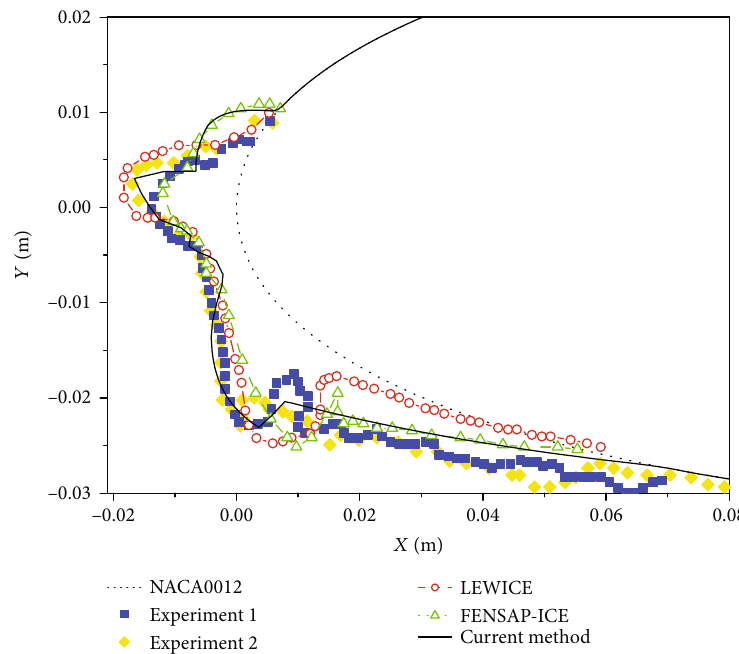
Figure 8: Comparison of glaze ice accretion between the current numerical result with LEWICE, FENSAP-ICE, and IRT experimental